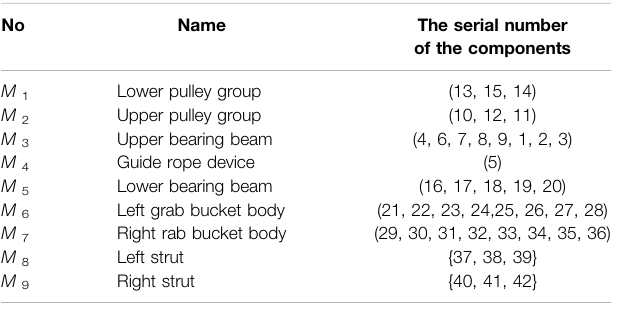
TABLE 4 | The name of each module and the serial number of the components it